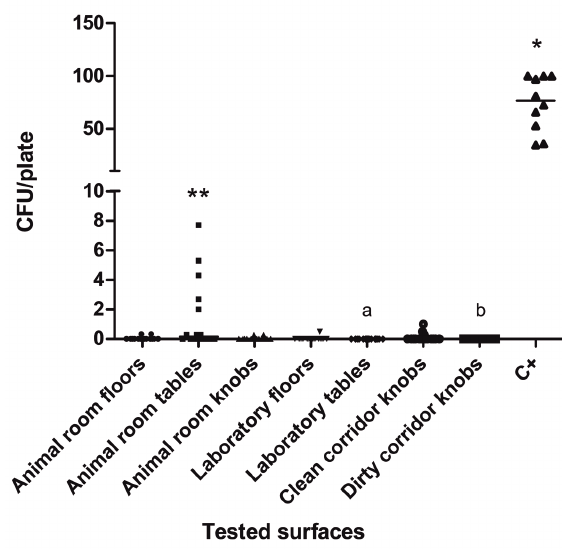
Figure 3 - Bacterial counts for TSA swabbing plates. Each dot represents the CFU registered each monitoring day (16 time points). The median (horizontal bar) is indicated for each type of surface and area. * p<0.01 difference from the positive control group. ** p<0.05 difference between Animal room tables and both Laboratory tables (a) and Dirty corridor knobs